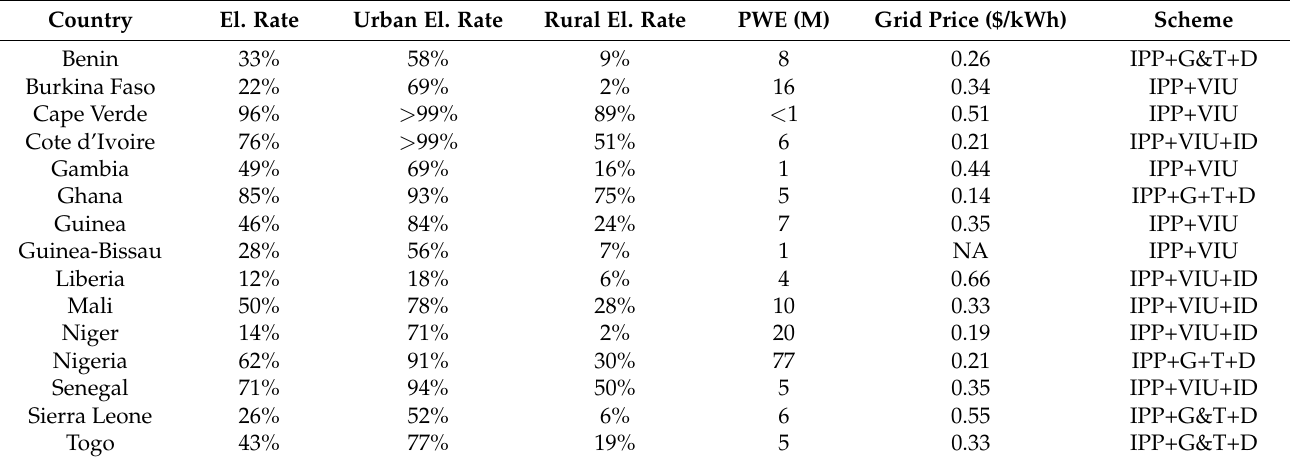
Table 1. Country information. National electrification rate (El. Rate), urban electrification (Urban El.), rural electrification (Rural El.), and population without electricity (PWE) in million people for 2019; data reproduced with permission from [20]. On grid charged electricity, data reproduced with permission from [22]. On grid scheme, where IPP stands for independent power producer, G generation, T transmission, D distribution, VIU vertical integrated utility and ID isolated distribution, data reproduced with permission from